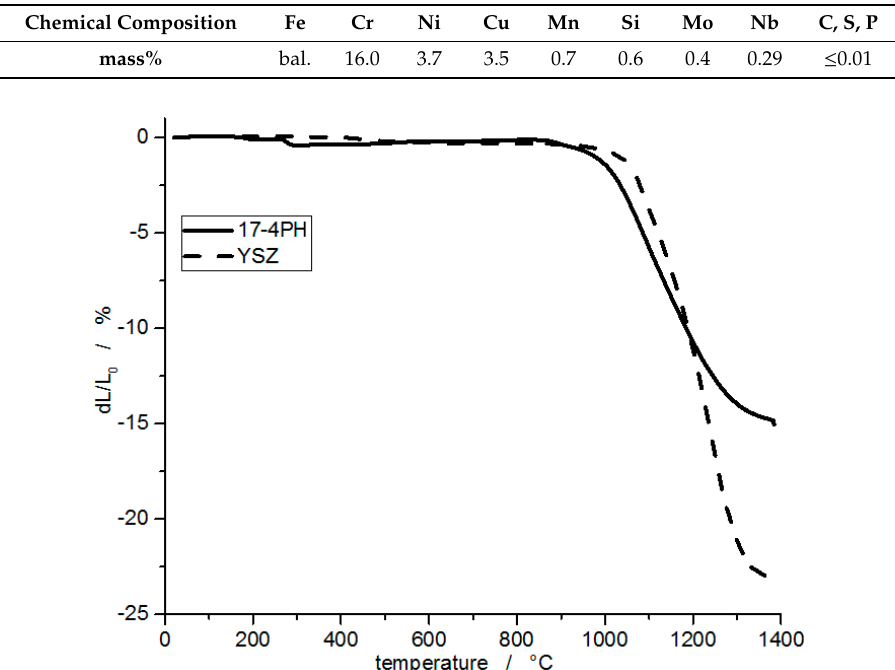
Table 1. Chemical composition of 17-4PH powder.